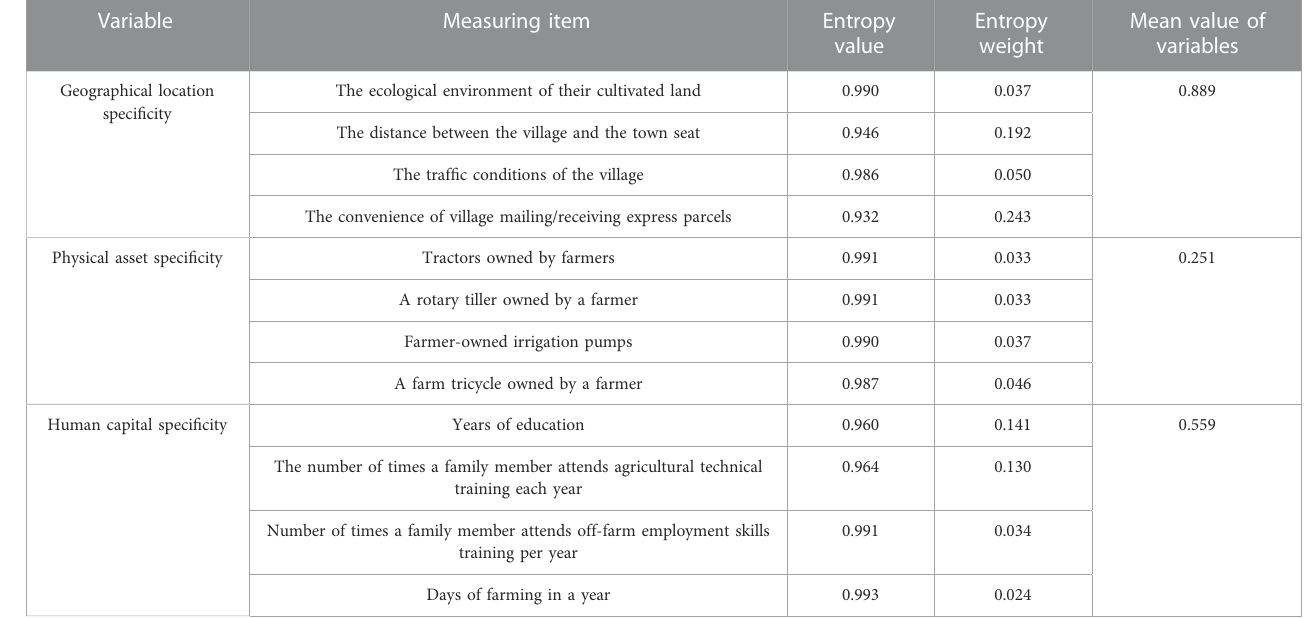
TABLE 1 Results of the asset speci fi city measure.